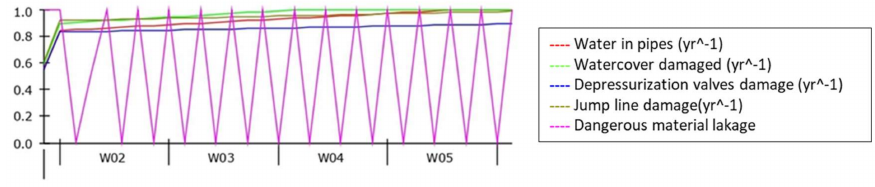
Figure 10. Mechanical system result.